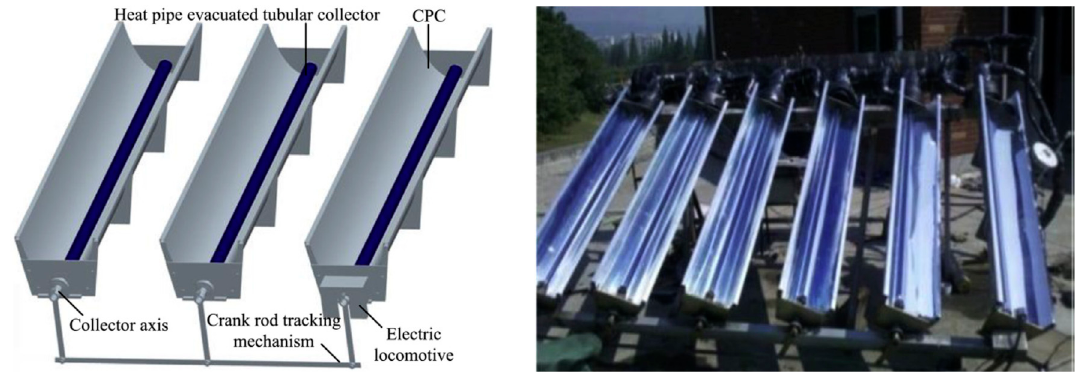
Figure 26. Schematic view of the north–south-axis TCPC (left: 3-D model; right: Experimental setup) [57].